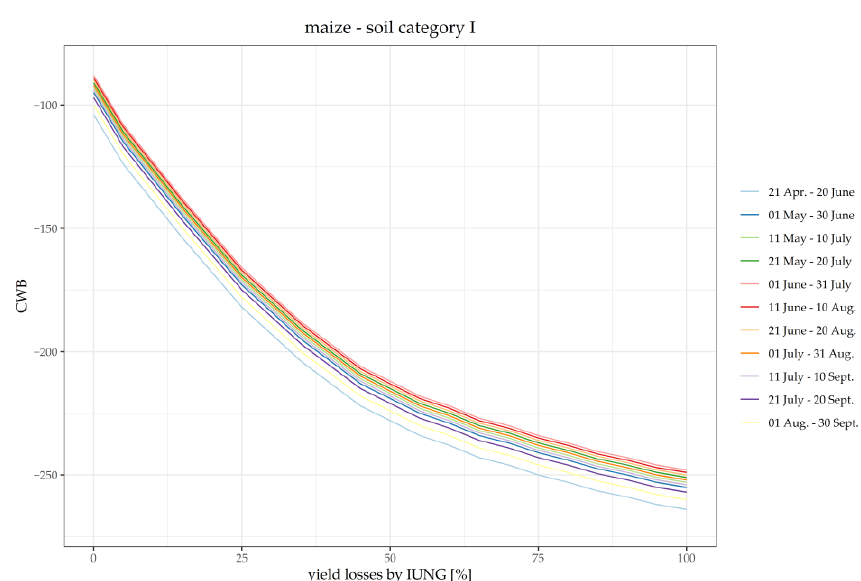
Figure A2. Yield reduction in maize grown on soils of the I category of soil drought vulnerability depending on the CWB values. Source: own study (IUNG-PIB).